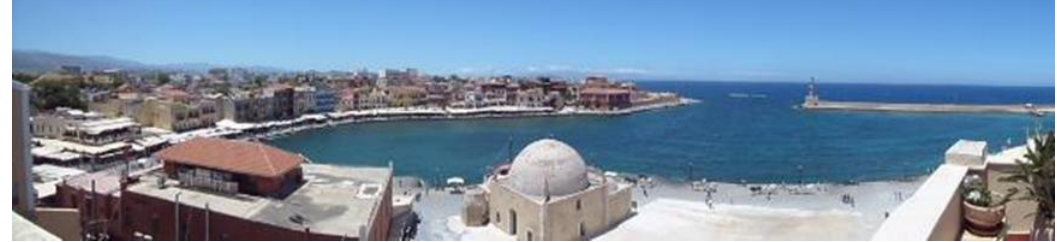
Figure 9. The interview site of the Old Port at Chania, island of Crete.